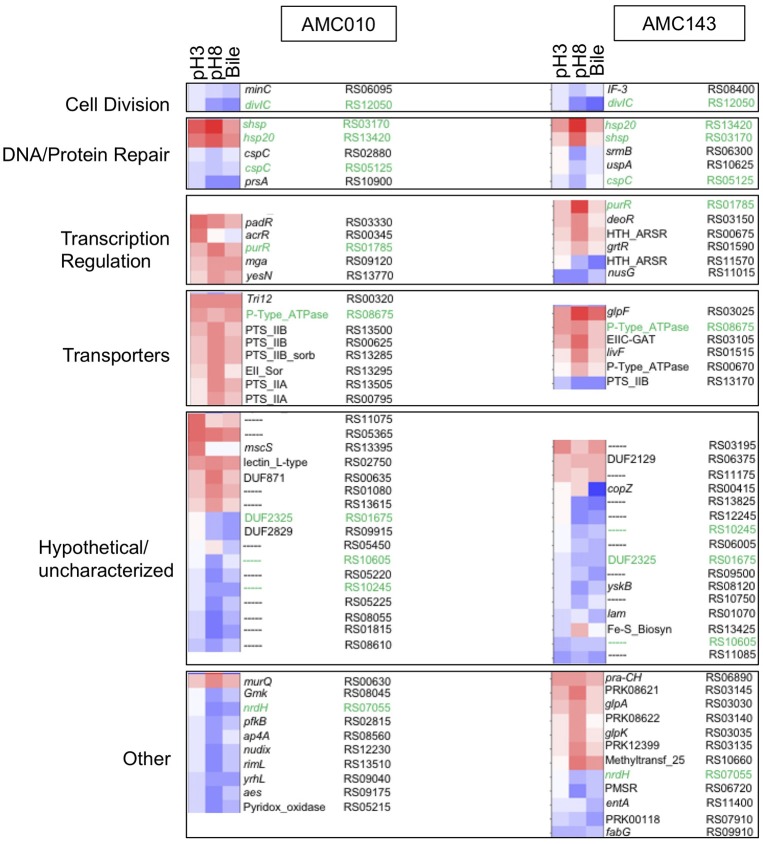
Transcriptomics analysis. mRNA sequencing data from each treatment (pH3, pH8, 0.5%, w/v Bile) was mapped to LGG genome and compared to untreated cells to calculate Log2 differential expression ratio and p-value. The 50 genes with the highest differential expression ratio (FDR corrected p ≤ 0.05) from each strain were categorized by function (cell division, DNA/protein repair, transcription regulation, and molecular transport) and plotted in OriginLab software. Highly differentially expressed hypothetical genes and genes with functions that did not fit into a defined category were also included. Green text highlights genes differentially regulated in both AMC010 and AMC143.